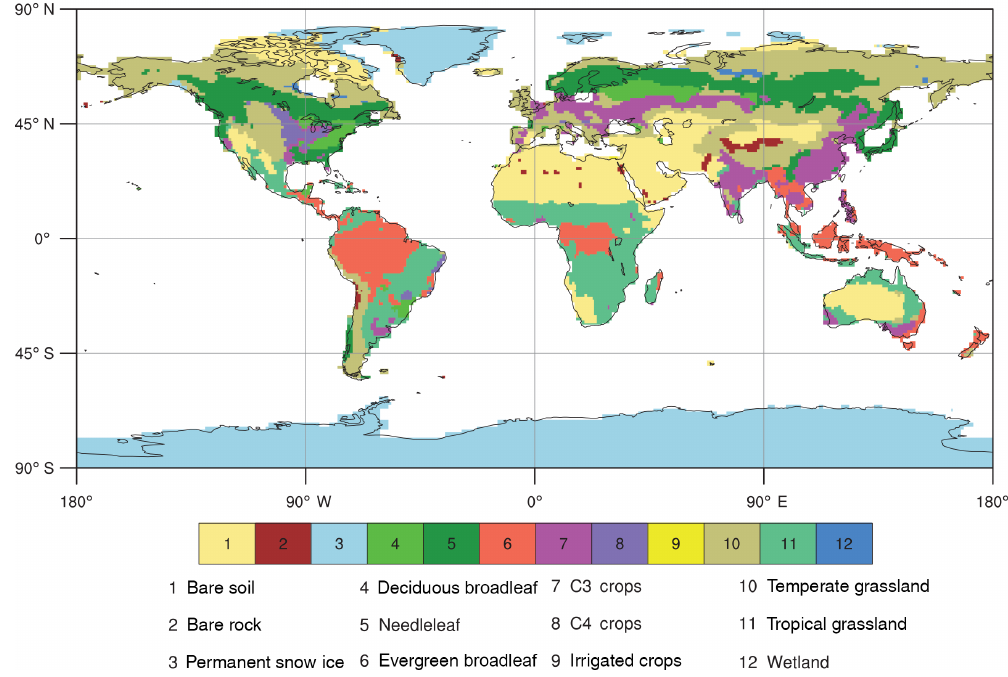
Figure 1. Fraction of dominant vegetation type as prescribed in SURFEX. This fraction results from aggregation of the various ECO- CLIMAP’s vegetation types at 1km resolution over the T127 CNRM-ESM1 horizontal grid ( ∼ 1.4 ◦ nominal horizontal